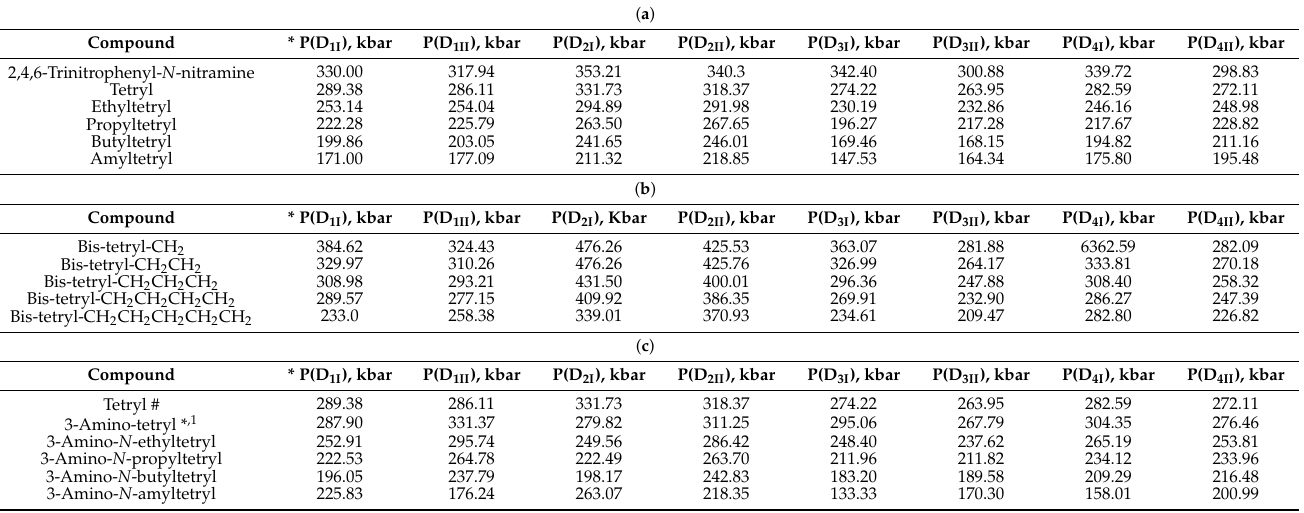
Table 4. The detonation pressure of the compounds belonging to ( a ) Homologous aromatic N -nitramines, tetryl derivatives [(2,4,6-trinitrophenyl-(O 2 N)N(CH 2 ) n H, n = 0–5]. ( b ) Bis-aromatic homologs of chain length variation (CH 2 ) n of [(2,4,6-trinitrophenyl-N(NO 2 )] 2 (CH 2 ) n , ( n = 1–5)]. ( c ) 3-Amino derivatives of tetryl with chain length variation [(3-amino-2,4,6-trinitrophenyl-(O 2 N)N(CH 2 ) n H, n = 1–5]